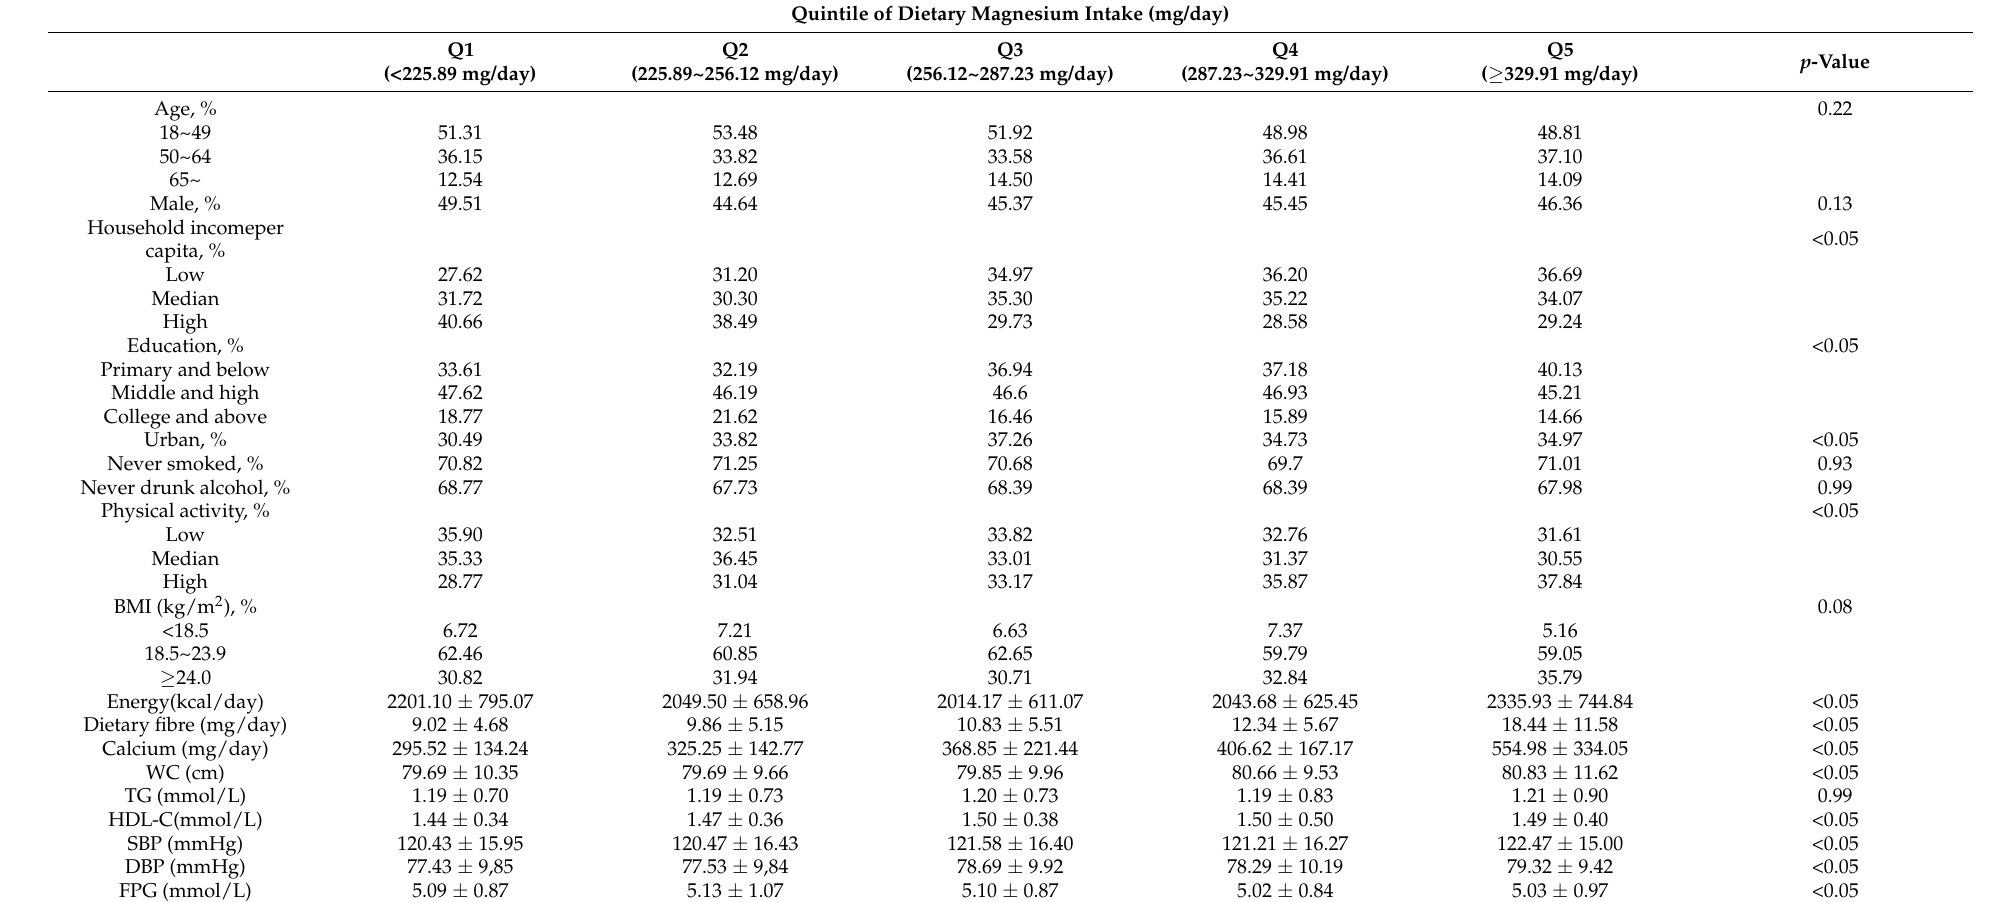
Table 1. Baseline characteristics according to quintile of dietary magnesium